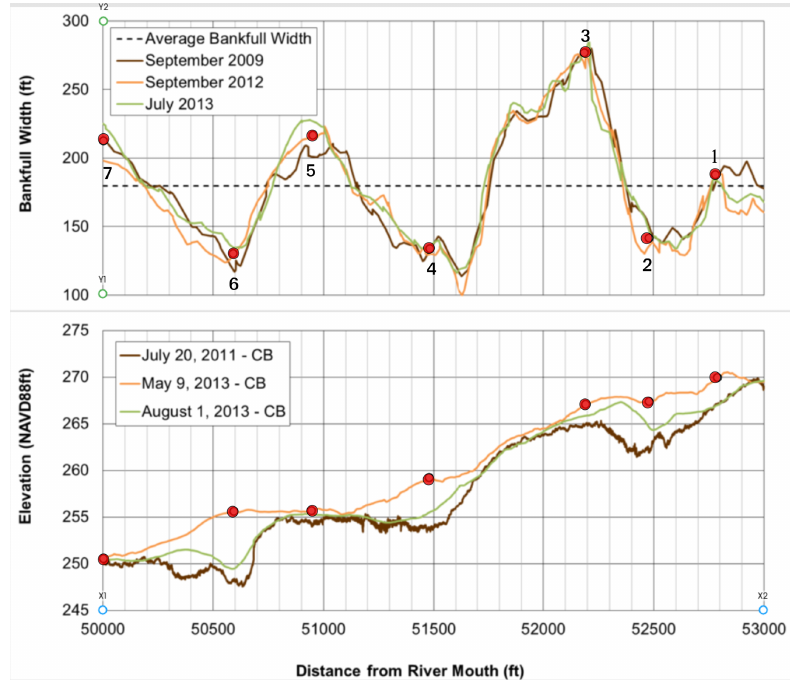
Figure B4. Modified Fig. 5 of Brew et al. (2015) showing the locations of channel width and elevation profile measurements indicated by the open circles. Width measurements are approximate averages of the three series shown. Elevation measurements were made for each profile by shifting the indicated points straight down to the next profile line below the top one (orange). Values are given in feet to remain consistent with the cited publication. To convert to SI units of meters multiply all values on the x and y axes by 0.3048. Flow is right to left in the image.